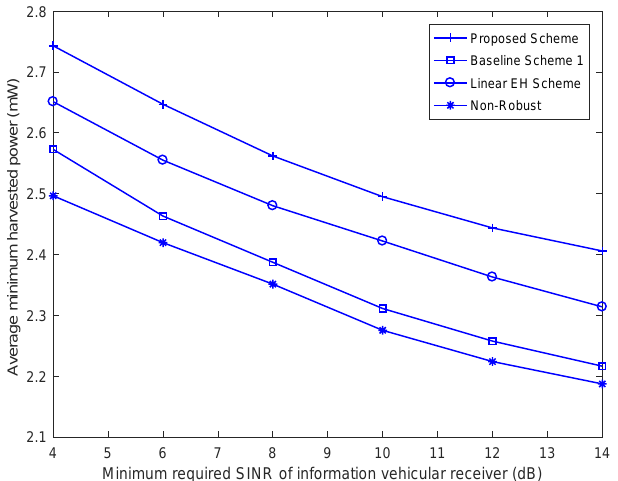
Figure 4. Average minimum harvested power per energy vehicular receiver versus the minimum required SINR of the information vehicular receiver, r